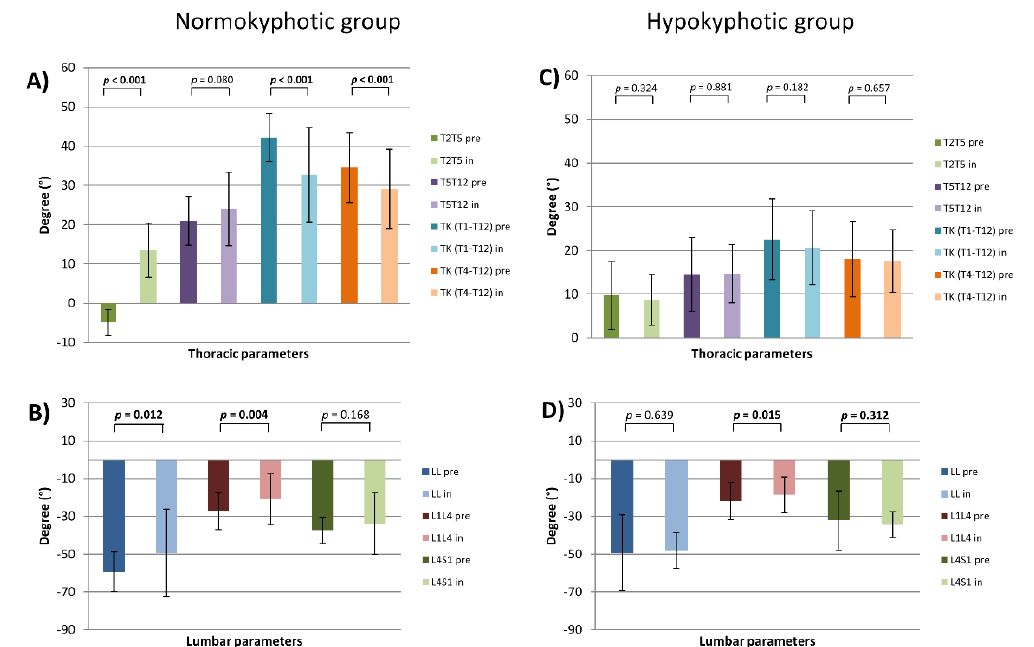
Figure 7. Thoracic and lumbar parameters by thoracic kyphosis (TK) stratified patients (pre- and in-brace). ( A ) thoracic and ( B ) lumbar parameters of the normokyphotic group. ( C ) thoracic and ( D ) lumbar parameters of the hypokyphotic group; p=statistical significance, p < 0.05.